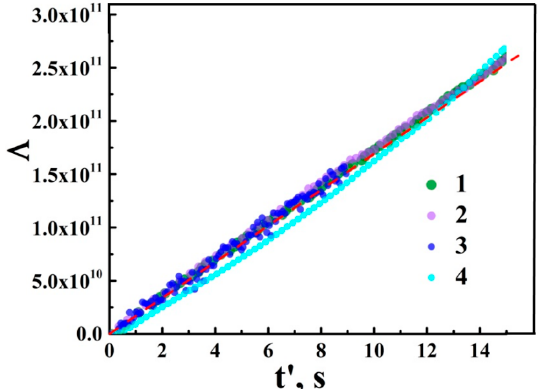
Figure 5. The recovered values Λ (the dimension of Λ is S 1 − ξ ) against the time lapse; (1) an after-sequence decay; irradiation conditions: the wavelength is 355 nm; the irradiation fluence is 3.5 mJ/cm 2 ; the repetition rate is 2 Hz; (2) an after-sequence decay; irradiation conditions: the wavelength is 355 nm; the irradiation fluence is 3.5 mJ/cm 2 ; the repetition rate is 2 Hz; (3) an after-pulse decay; irradiation conditions: the wavelength is 355 nm; the irradiation fluence is 3.5 mJ/cm 2 ; the repetition rate is 0.1 Hz; (4) an after-sequence decay; irradiation conditions: the wavelength is 355 nm; the irradiation fluence is 4 mJ/cm 2 ; the repetition rate is 10 Hz. The red dashed line is displayed as a guide for the eye and corresponds to the linear dependence Λ on the time lapse retrieved with ξ ≈ 2.62 and K ≈ 1.7 × 10 10 S 1 − ξ /s.